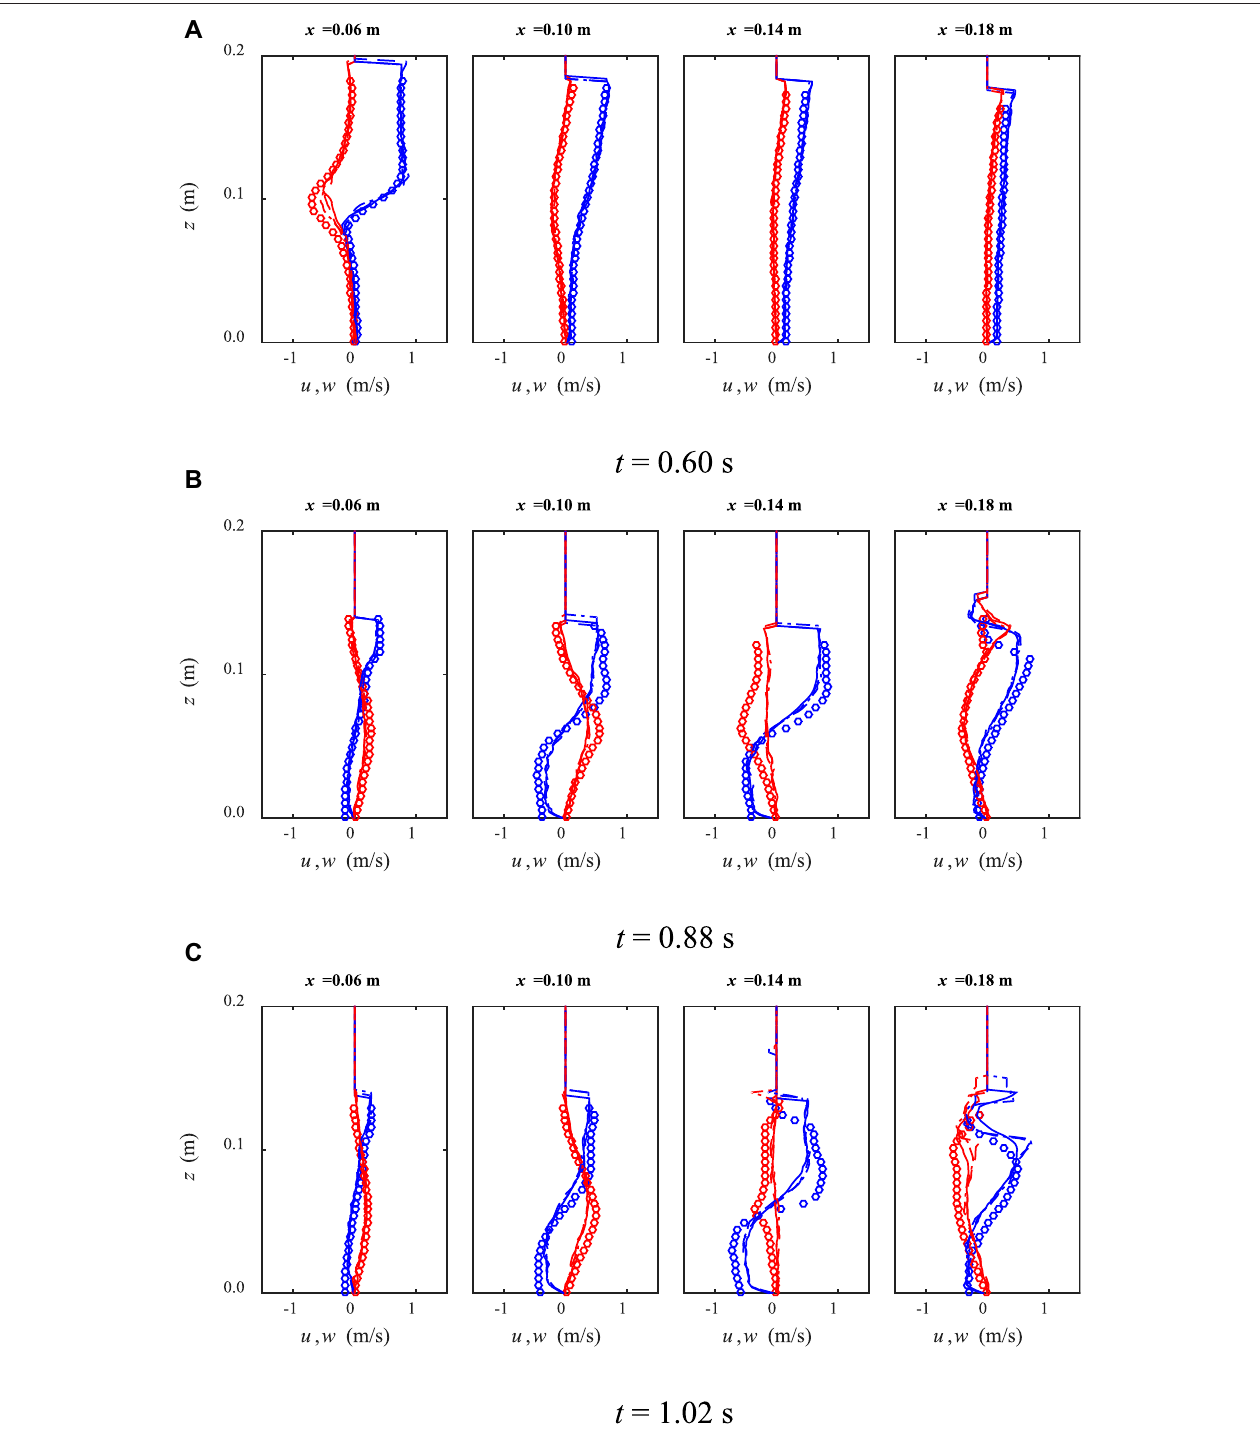
FIGURE 5 | Comparisons between experimental data (circles) and numerical results for the horizontal u (blue) and vertical w (red) velocity pro fi les, calculated by k - ε model (solid lines), SPS model (dashed lines) and non-turbulence model (dash-dotted lines) at three times t (cid:2) (A) 0.60 s; (B) 0.88 s; and (C) 1.02